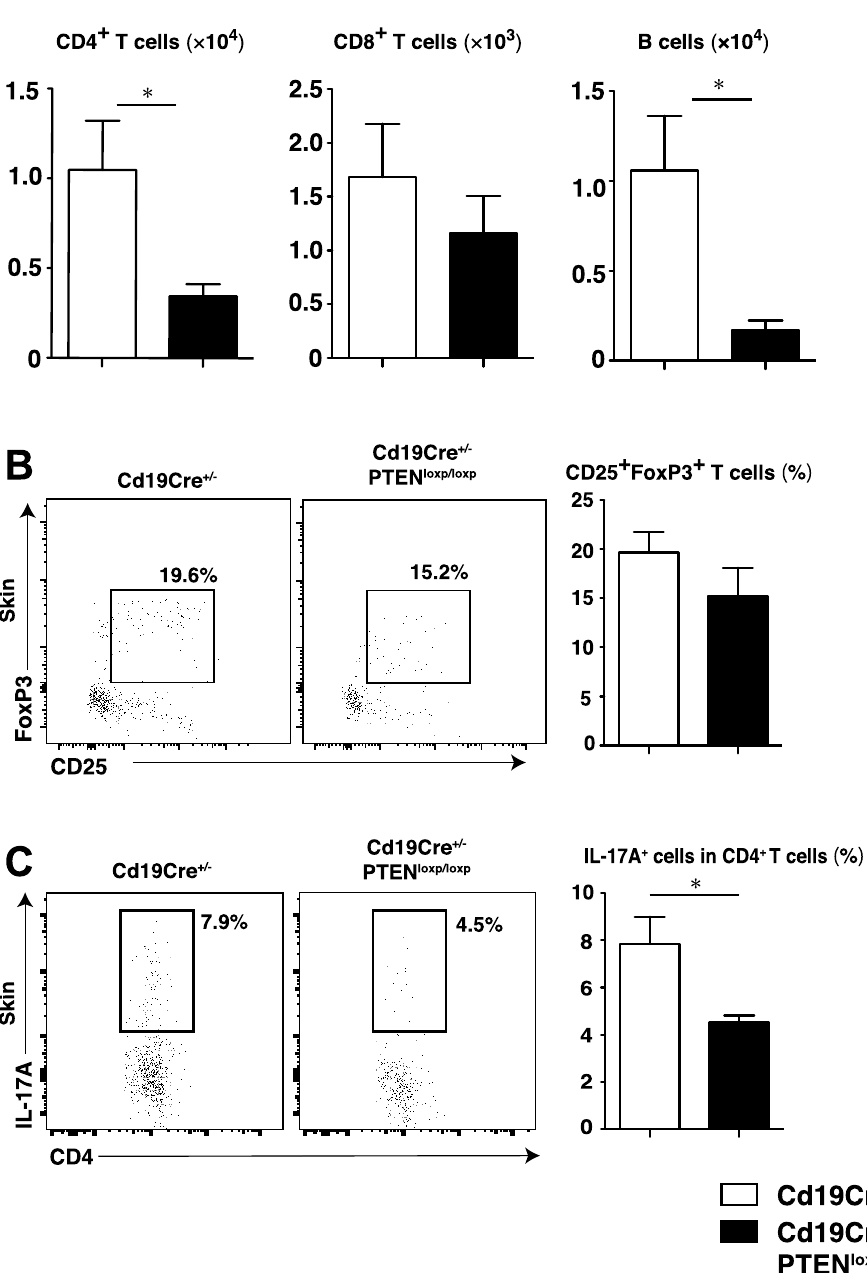
Figure 5. Th17 differentiation in rmIL-23-injected ears was suppressed in B cell-specific PTEN-deficient mice. The number of CD4 + T cells, CD8 + T cells, and B cells in the inflamed skin of rmIL-23 injected Cd19Cre + /− and Cd19Cre + /− Pten loxP/loxP mice ( A ). The frequencies of CD25 + FoxP3 + T cells ( B ) and CD4 + IL-17A + T cells in the inflamed skin of rmIL-23-injected Cd19Cre + /− and Cd19Cre + /− Pten loxP/loxP mice ( C ). The images were created with FlowJo software (version 10.1R5; Tree Star, San Carlos, CA, USA, https ://www.flowj